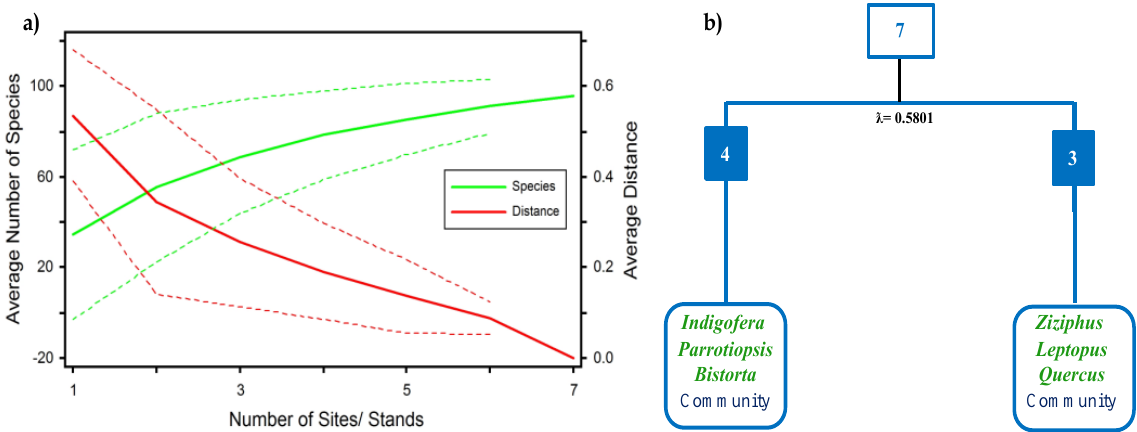
Figure 2. Compilation of records of plant diversity along the ecological gradients in the Himalayan Subtropical-Temperate Ecotone/Evergreen Oak Forest of the study area: ( a ) The species area curves of 97 plant species distributed among seven sampling sites; ( b ) TWINSPAN classification of the Himalayan Subtropical-Temperate Ecotonal zone of Manoor Valley.